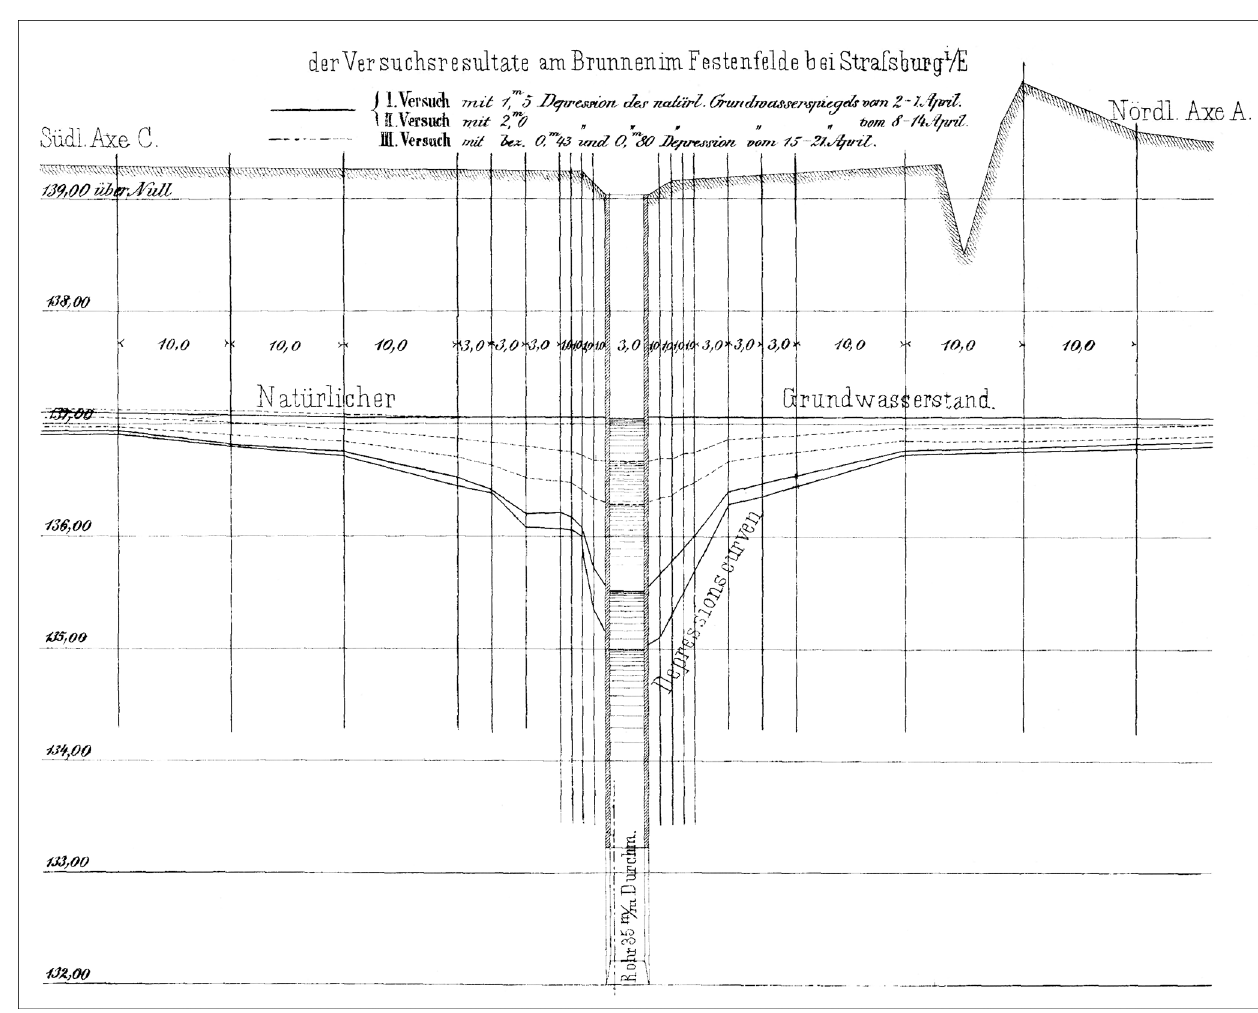
Figure 3. Sketch of the cones of depression for different flow rates obtained during pumping tests in Festenfeld near Strassburg, Alsace. The vertical black lines are the logarithmically (10, 3, and 1m spacing) arranged observation wells (Thiem, 1876b). Note: Natürlicher Grund- wasserstand is the natural groundwater level; Rohr is the well diameter of 35mm; Depressionskurven is the pumping level curves; Versuch is the test; Versuchsresultate is the test results; über Null stands for above (French) sea level; Südl./Nördl. Axe is the southern/northern